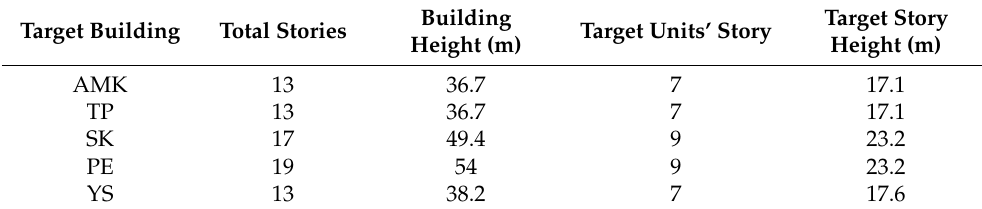
Table 2. Total story numbers and building heights of the target units.